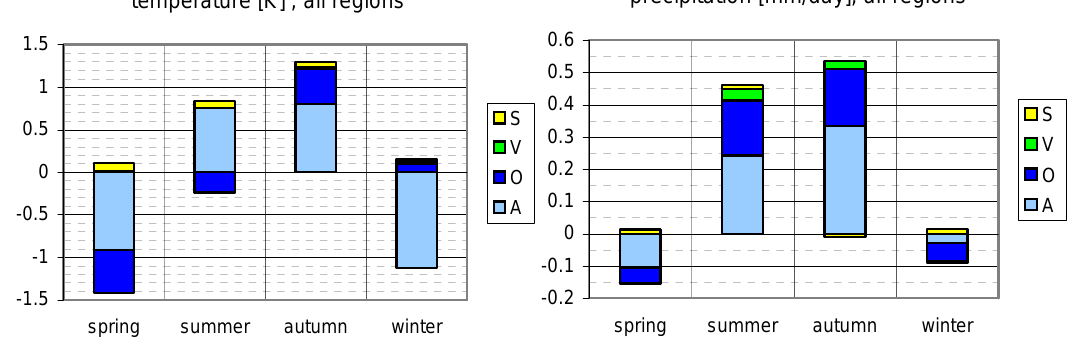
Fig. 14. Same as Fig. 5, but averaged over all six regions and periods. Robust as well as not robust contributions of the different factors are taken into account: left panel: temperature [K]; right panel: precipitation